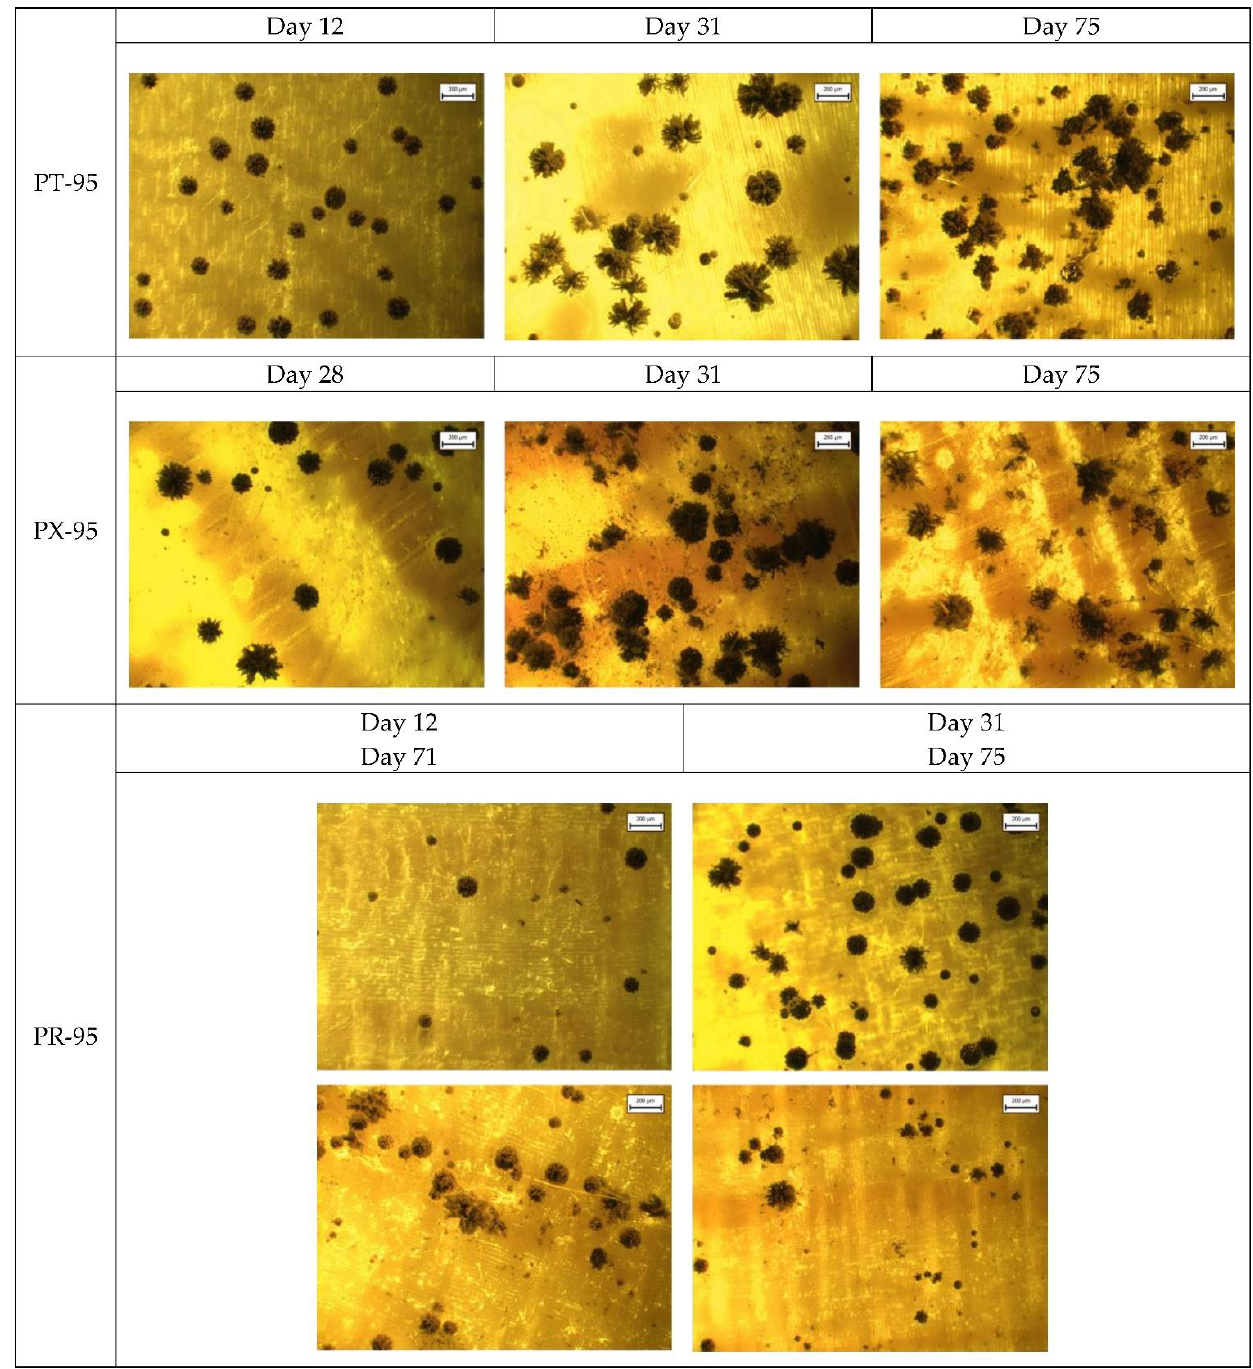
Figure A2. Selected microscopic images for subsets PT-95, PX-95, PR- 95 (bar is 200 μm).